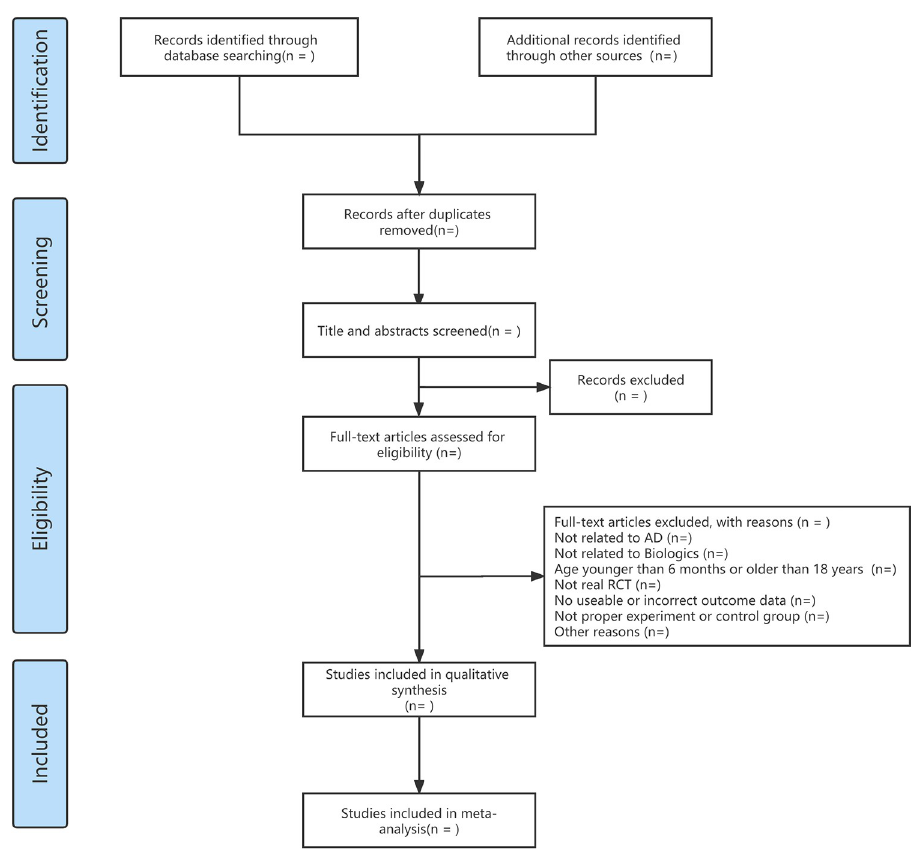
Fig 1. Flow diagram of the study selection